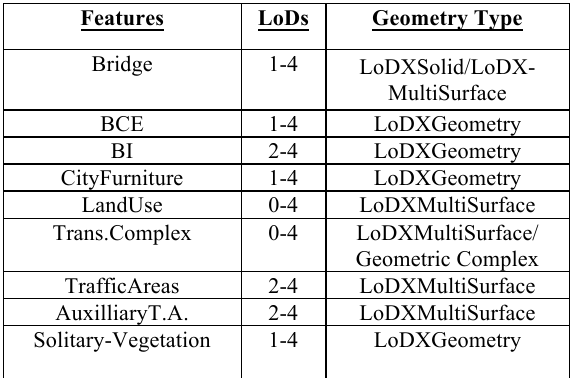
Table 1: LoDs and Geometry Types of the applied Features